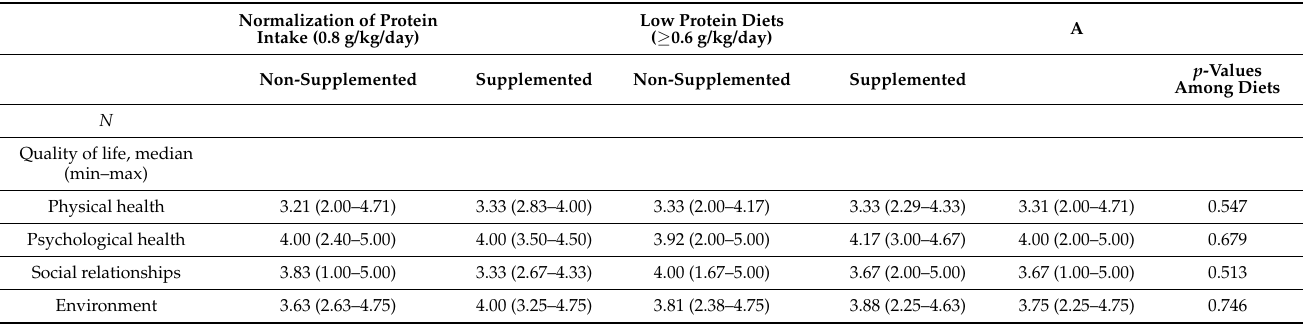
Table 3. Quality of life in patients sorted according to their diet